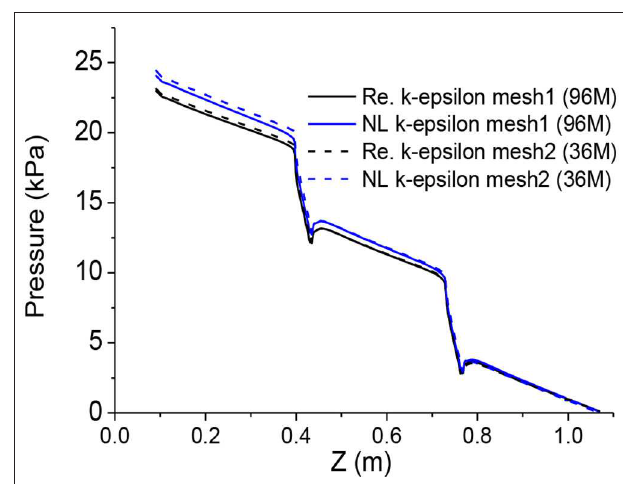
FIGURE 9 | Mesh sensitivity on pressure drop along the line (X, Y)